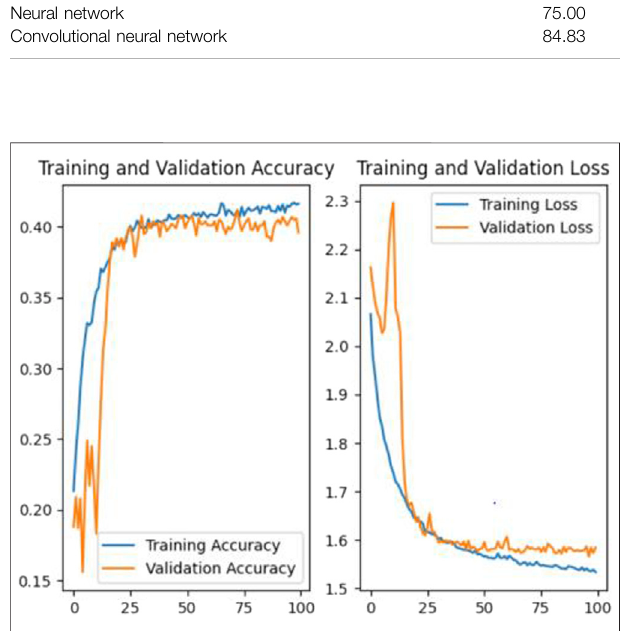
FIGURE 8 | Model training process without considering life